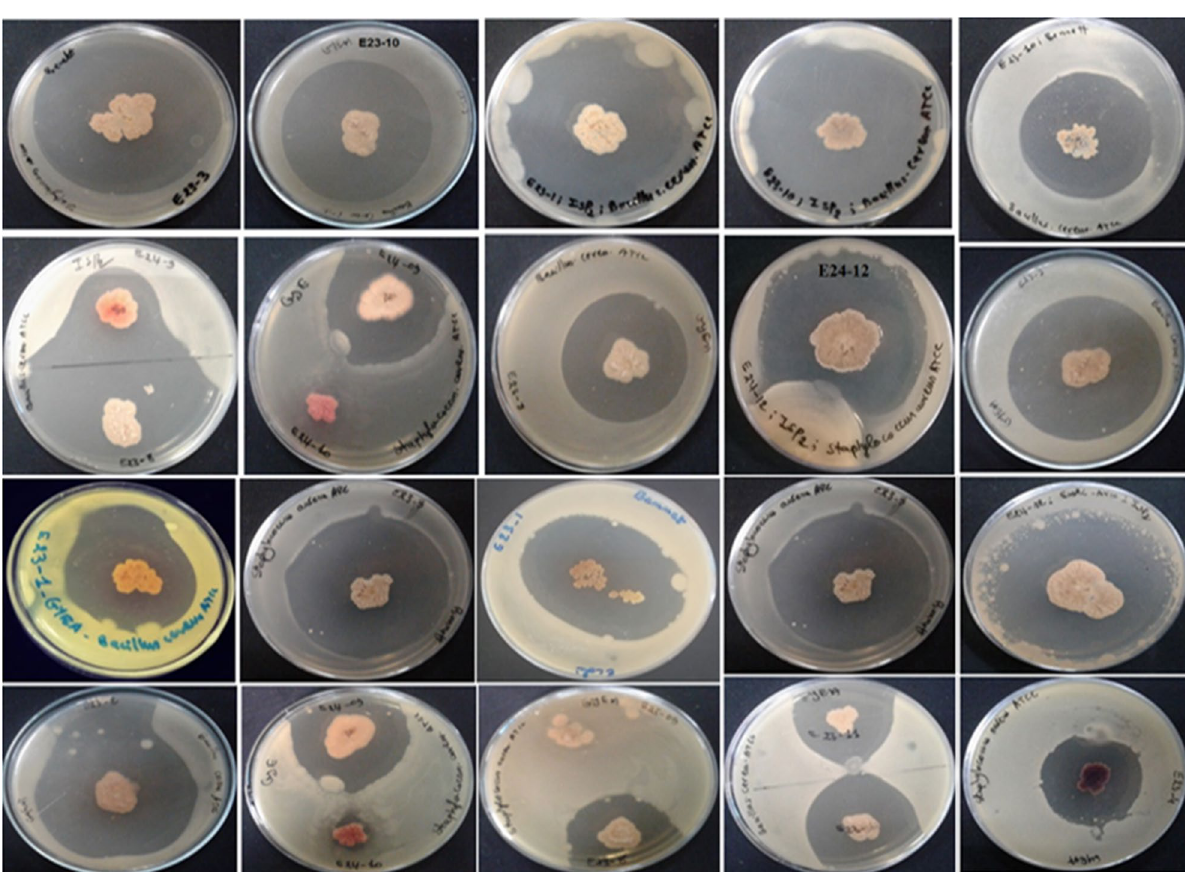
Figure 2. Antibacerial activity of pure Actinomycetes isolates by the double layer method on ISP2